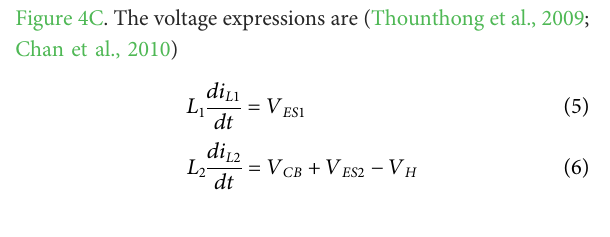
Figure 4C. The voltage expressions are (Thounthong et al., 2009;